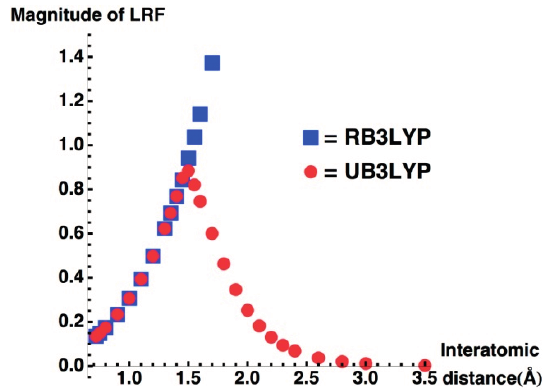
Figure 8. Interatomic distance of H 2 versus magnitude of LRF (